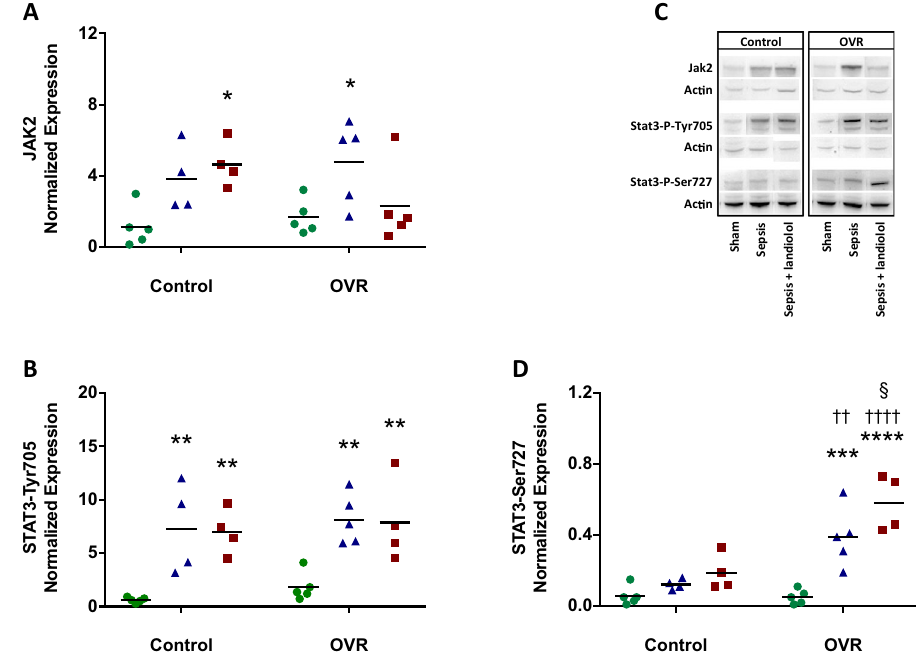
Figure 3. Left ventricular JAK2 expression and STAT3 phosphorylation assessed by western-blot in sham (n = 5), sepsis (n = 4), sepsis plus landiolol (n = 4), OVR-sham (n = 5), OVR-sepsis (n = 5) and OVR-sepsis plus landiolol (n = 4). ( A ) JAK2 expression. ( B ) STAT3-Tyr705 phosphorylation. ( C ) The phosphorylation of STAT3 and the expression of JAK2 were normalized to actin on stripped blot. ( D ) STAT3-Ser727 phosphorylation. *p < 0.05; **p < 0.01; ***p < 0.001; ****p < 0.0001 vs sham and vs OVR-sham, respectively. § p < 0.05 vs OVR-sepsis. †† p < 0.01; †††† p < 0.0001 vs control of corresponding